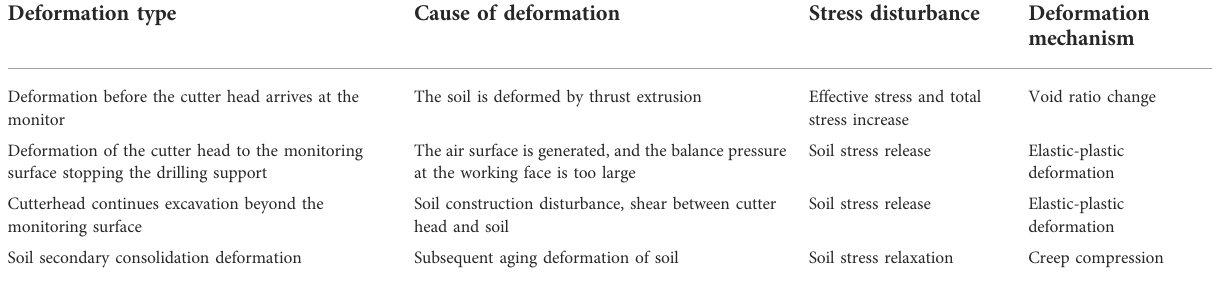
TABLE 2 Relationship between surrounding rock deformation and stress